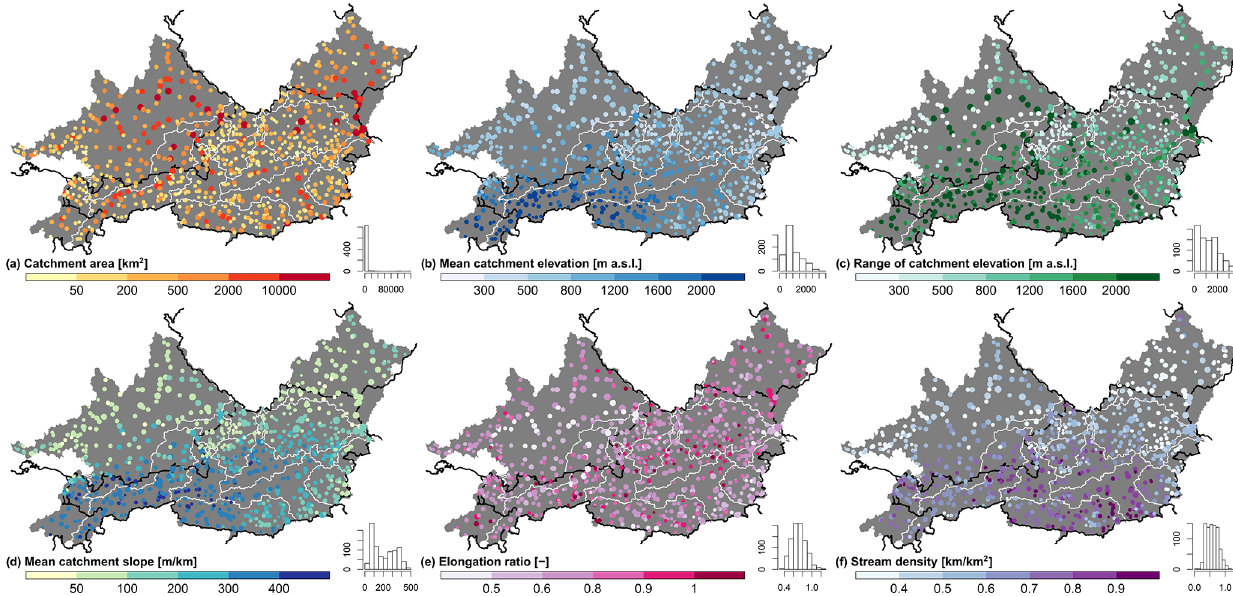
Figure 5. Spatial distribution of a selection of topographic attributes representing the characteristics of the entire topographic catchment (basin delineation A, Fig. 2a). The histograms indicate the number of basins (out of 859) in each category. The size of the circles is propor- tional to the catchment area. © EuroGeographics for the administrative